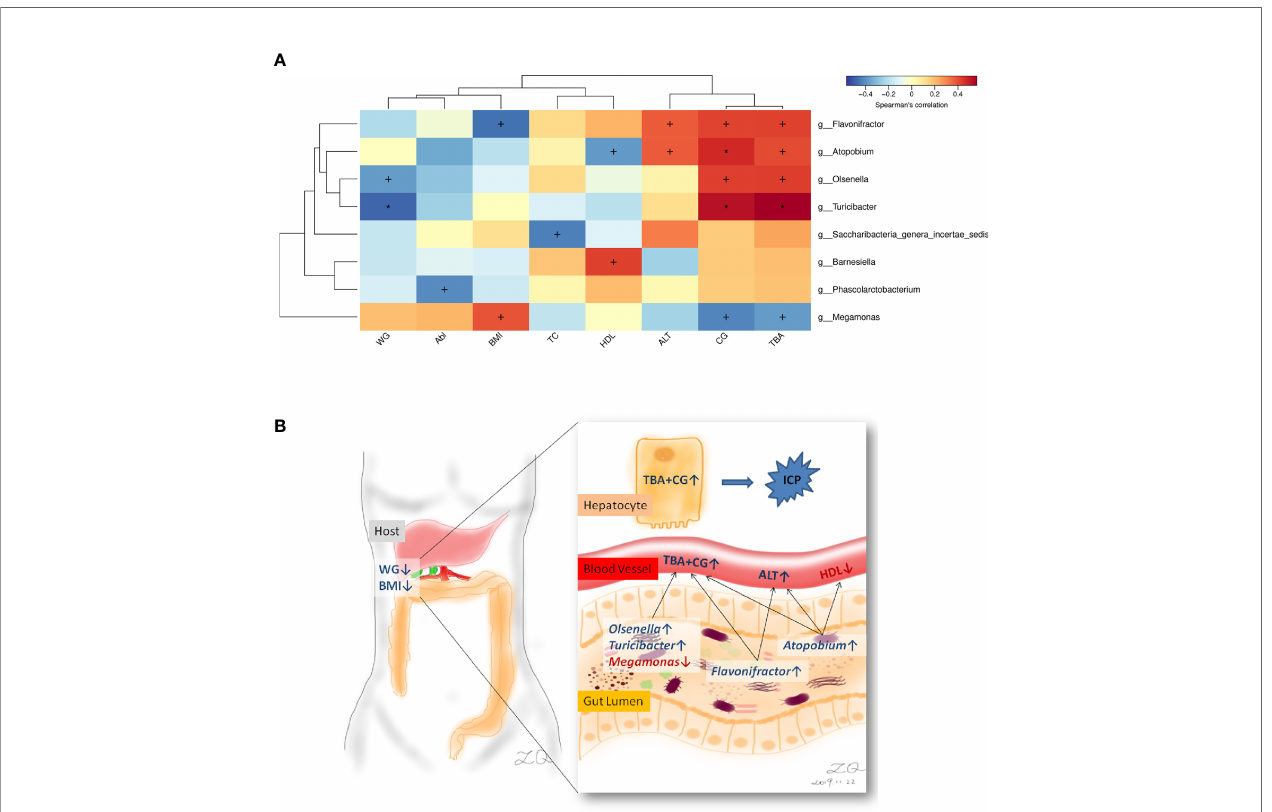
FIGURE 4 | Correlations between the genera and ICP clinical characteristics. (A) Heatmap of correlations. (B) Schematic diagram showing the main genera of the gut microbes that had a predicted ICP association. Enriched genera and higher chemical indicators were shown in blue, depleted genus and lower chemical and clinical indicators were shown in red. WG, Weight that gained during pregnancy; BMI, body mass index; Alb, albumin; TC, total cholesterol; HDL, high-density lipoprotein; ALT, alanine aminotransferase; CG, cholyglycine; and TBA, total bile acid. + p < 0.05, * p <